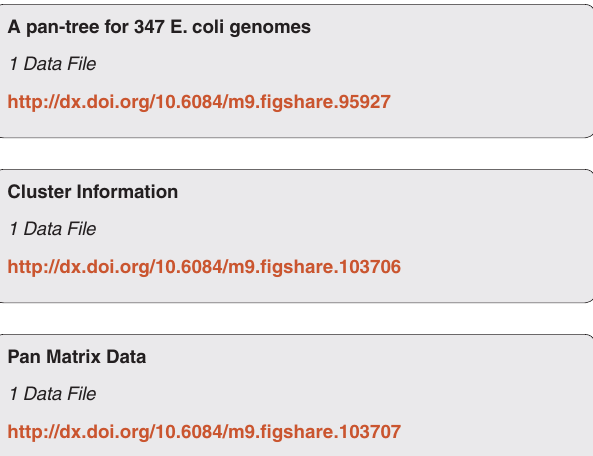
dark blue dots) is clearly visible. The collection of diarrheagenic strains (red dots) are clumped at several locations, indicating a mix- ture of functional content. The Human Microbiome Project strains (green dots) are all located to the right hand side of Figure 6.